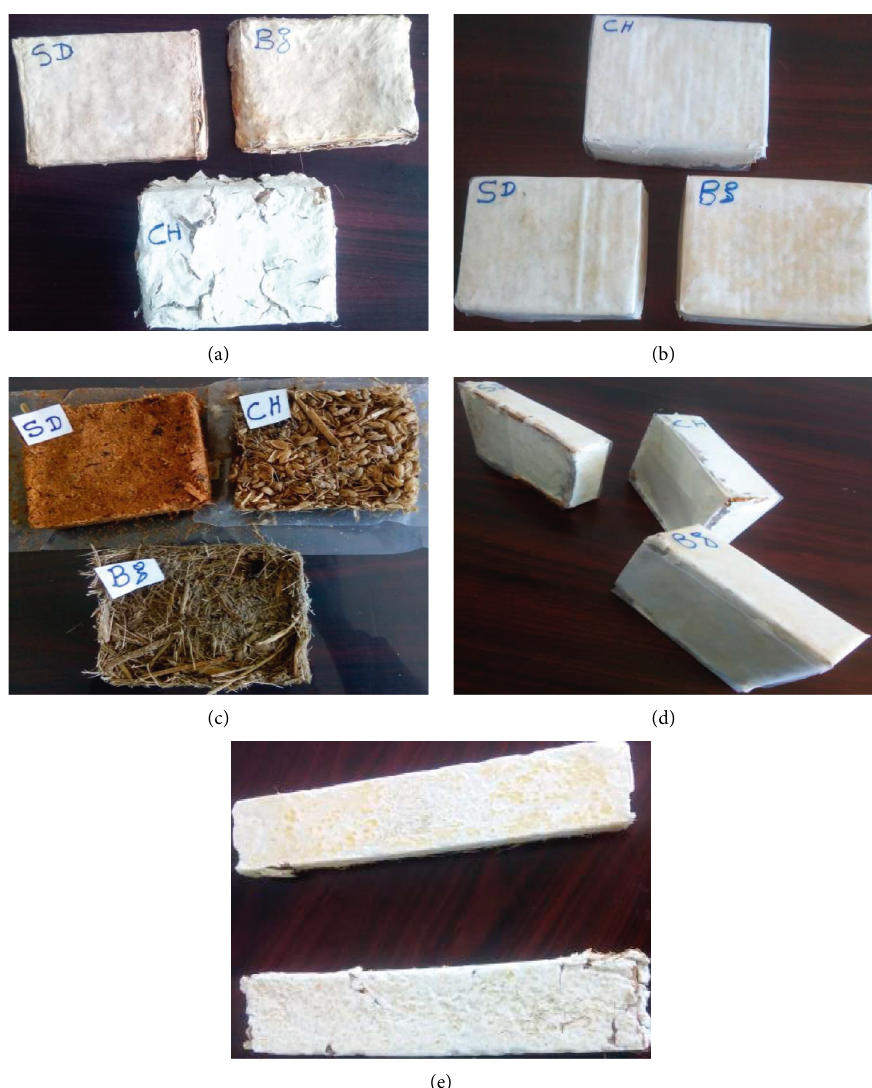
Figure 4: Image showing Mycoblock made from different substrates: (a) heat exposed, (b) nonheat exposed, (c) control, (d) block side view, and (e) rectangular